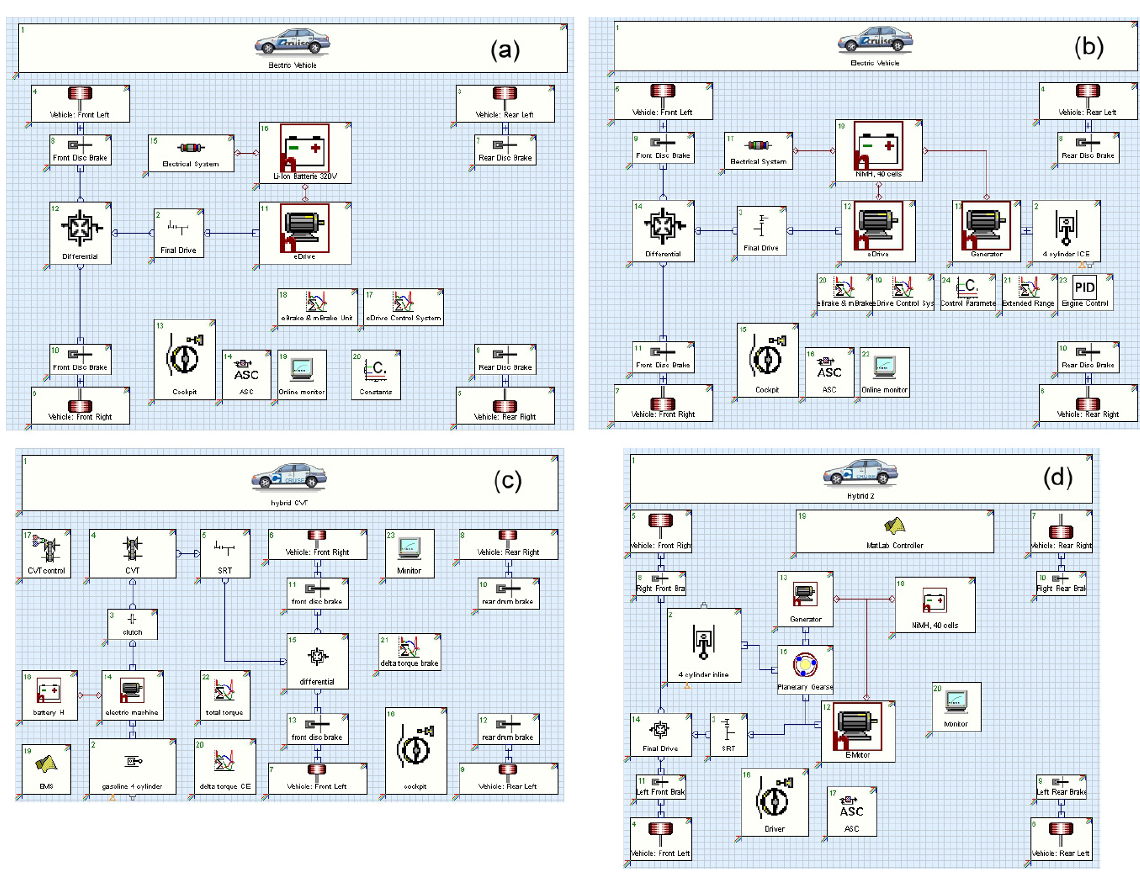
Figure 4. Cruise block diagrams for: Electric vehicle (a), Electric vehicle with range extender (b), Hybrid vehicle with CVT (c), Hybrid vehicle with planetary gearbox